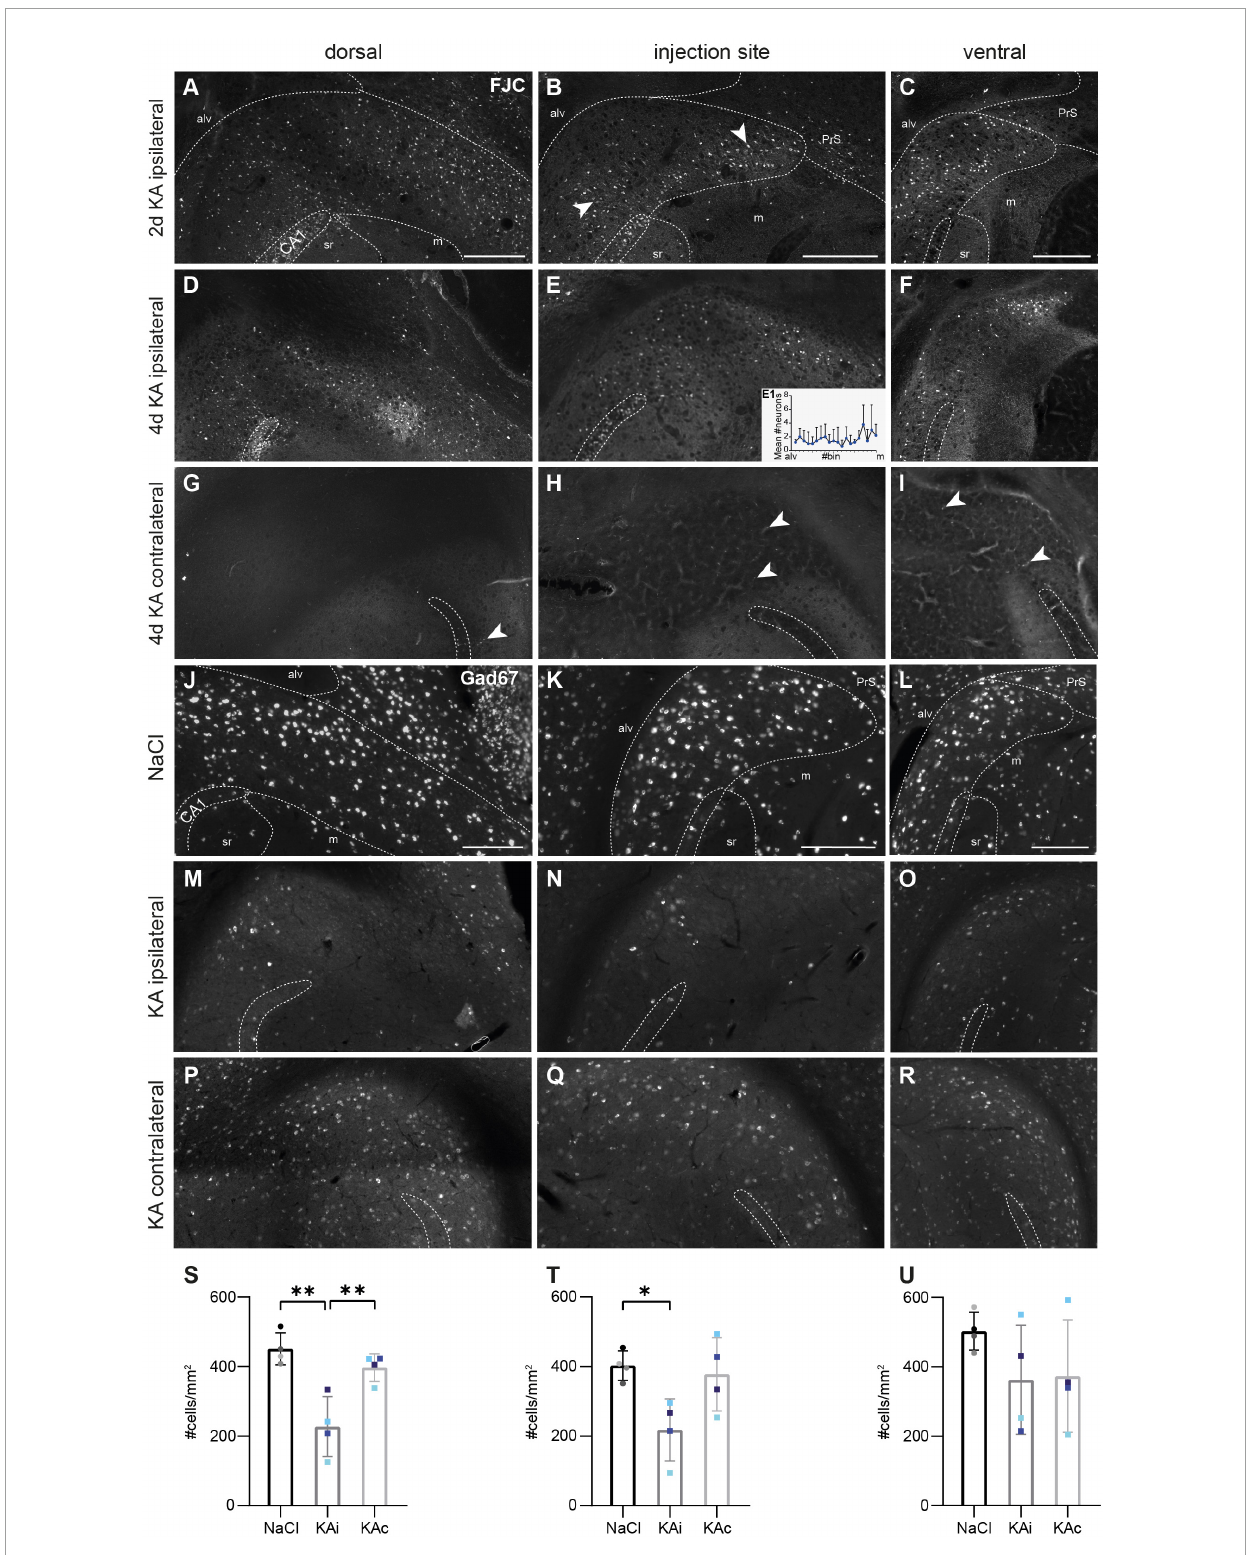
FIGURE2 Degenerating neurons in the ipsilateral subiculum early after kainate (KA) injection and strong loss of GABAergic interneurons in the chronic stage. (A–I) Representative images of FluoroJade C (FJC)-stained degenerating neurons at 2 days (A–C) and 4 days after KA injection (D–I) along the DV axis. The localization of the CA1 pyramidal cell layer is indicated. The borders of the subicular pyramidal cell layer toward the alveus (alv) and the molecular layer (m) are delineated as dashed lines according the brain atlas (Franklin and Paxinos, 2008). (A) At 2 days after KA, FJC + cells are distributed throughout the pyramidal cell layer of the dorsal ipsilateral subiculum. (B) At the level of the injection site, FJC-stained neurons are mainly located in the part of the pyramidal cell layer adjacent to the molecular layer. Degenerating neurons are densely placed in the proximal subiculum close to CA1 and distally, close to the presubiculum (arrowheads). (C) Similar pattern in the ventral subiculum. (D–F) At 4 days